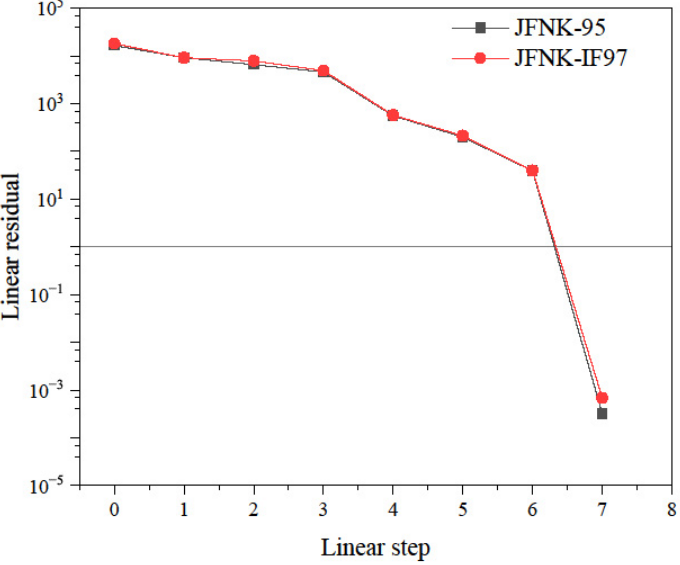
Figure 7. Linear residual history in steady-state HTR-10 steam generator simulation.